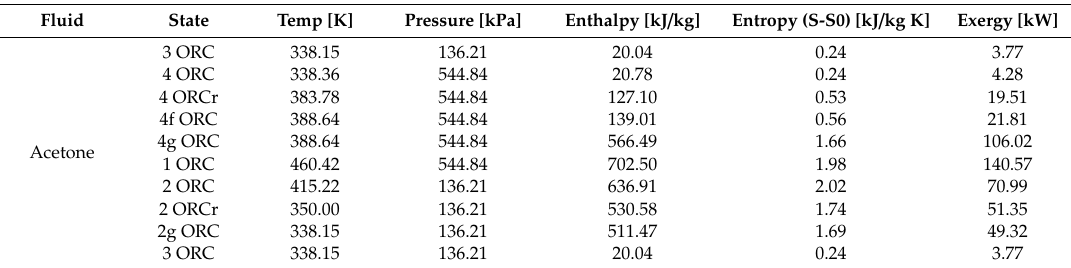
Table 5. Thermodynamic properties of the waste heat recovery system (WHRS) system based on RORC system for acetone as working